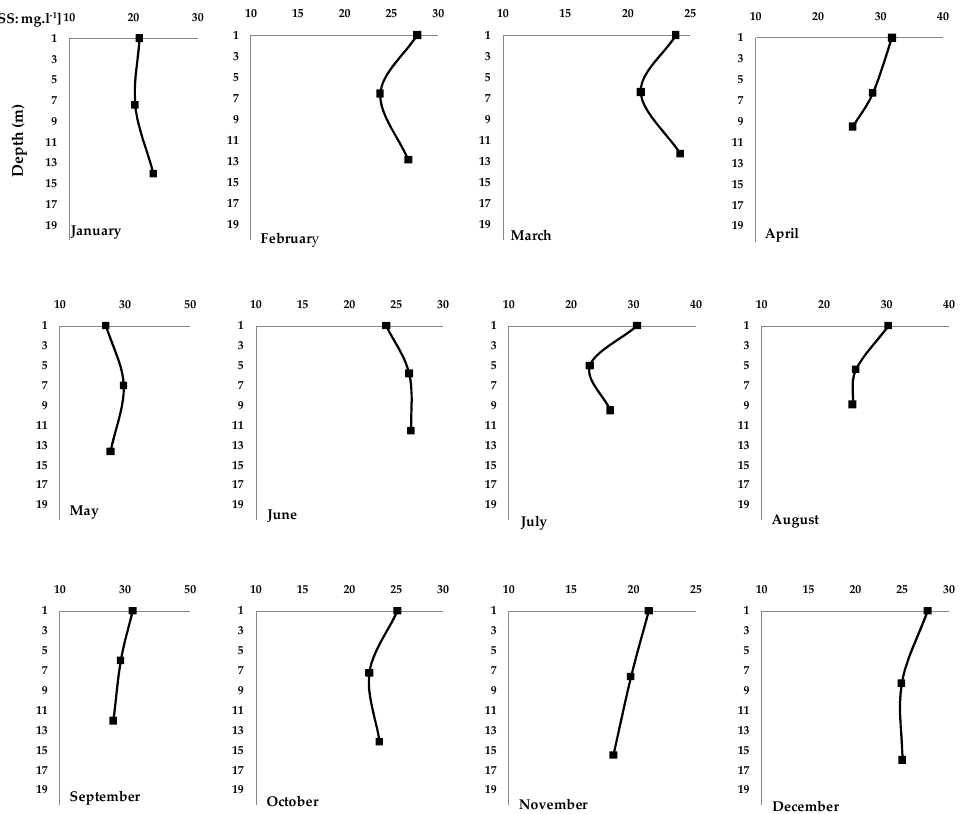
Figure 9. Spatial and temporal distribution of mean monthly TSS concentration (during the period January 2013–December 2017) at three point of the water column (Surface, Middle, Bottom). On the x-axis are the TSS concentrations (mg L − 1 ) and on the y-axis the depth (m).